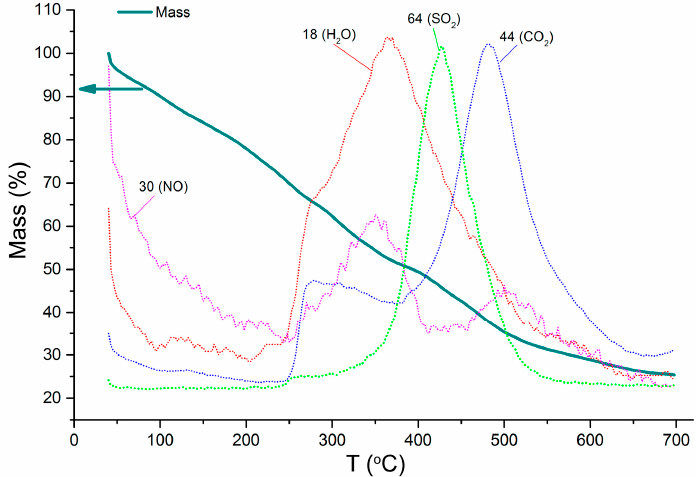
Figure 1. TG curve and temperature dependencies of ionic current for m / z = 18 (H 2 O), 30 (NO), 44 (CO 2 ), 64 (SO 2 ) for SnS 2 oxidation in air.